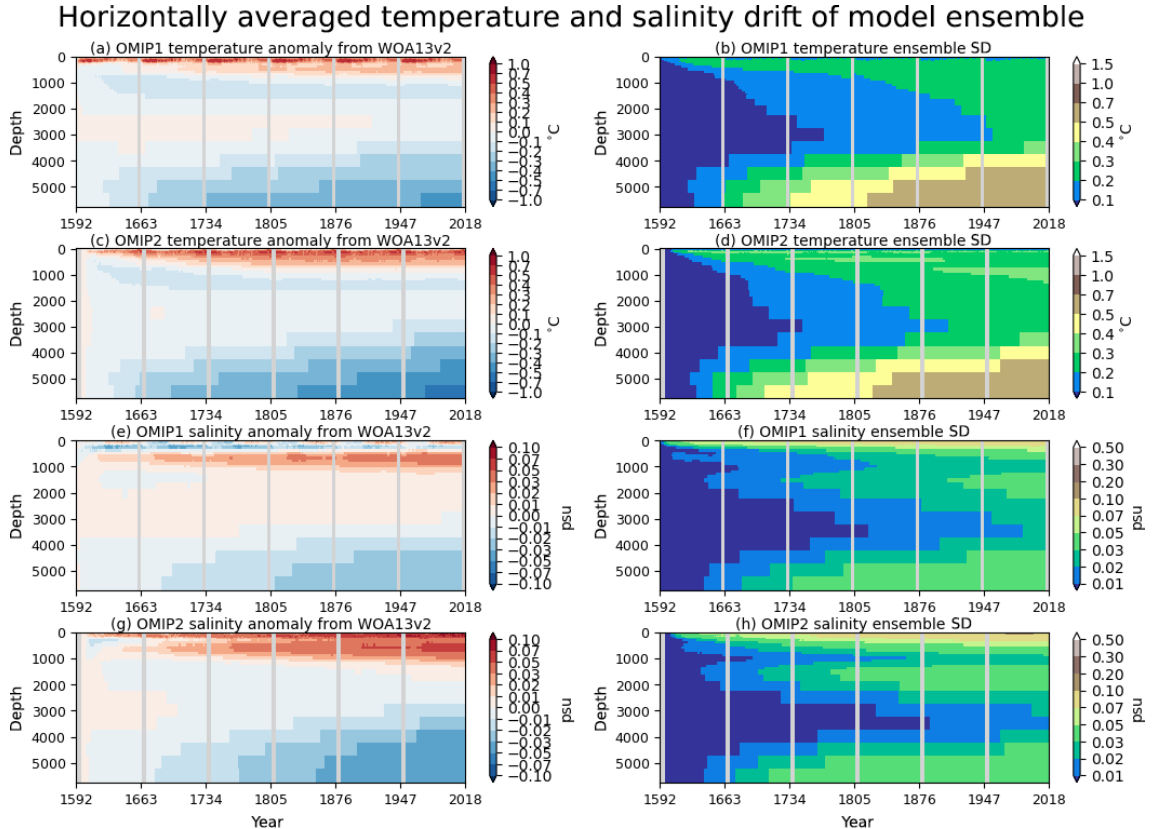
Figure 3. Globally averaged drift of multi-model mean horizontal mean (a, c) temperature ( ◦ C) and (e, g) salinity (psu) as a function of depth and time. The drift is defined as the deviation from the annual mean of the initial year of the simulation by each model. For each, time evolution of the standard deviation of the model ensemble is depicted to the right. (a, b) OMIP-1 temperature, (c, d) OMIP-2 temperature, (e, f) OMIP-1 salinity, and (g, h) OMIP-2 salinity. See Figs. S3–S6 for results of individual